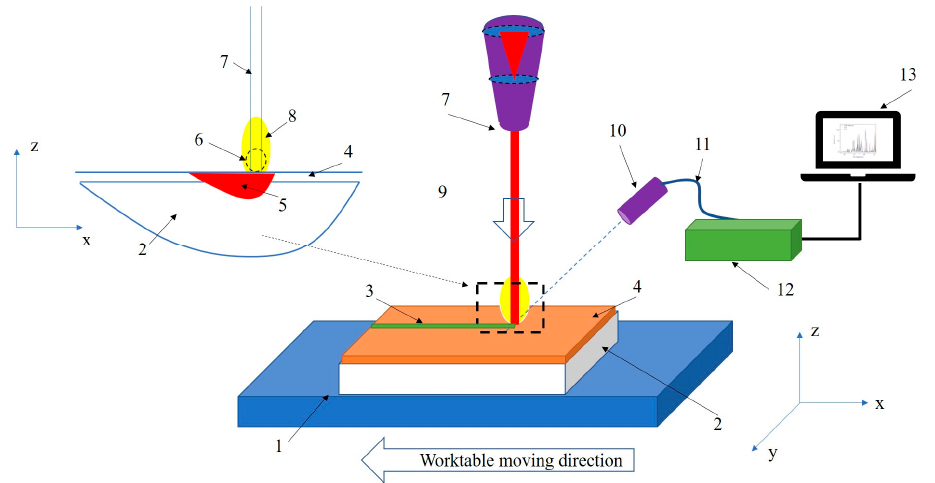
Figure 2. Schematic diagram of the experimental system. 1: Worktable; 2: Substrate; 3: Cladding zone;